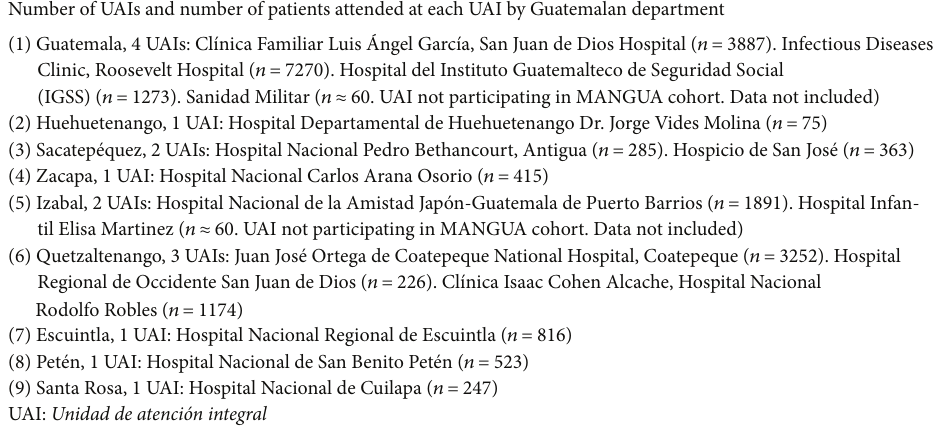
Figure 1: Number of UAIs and number of patients attended at each UAI by Guatemalan